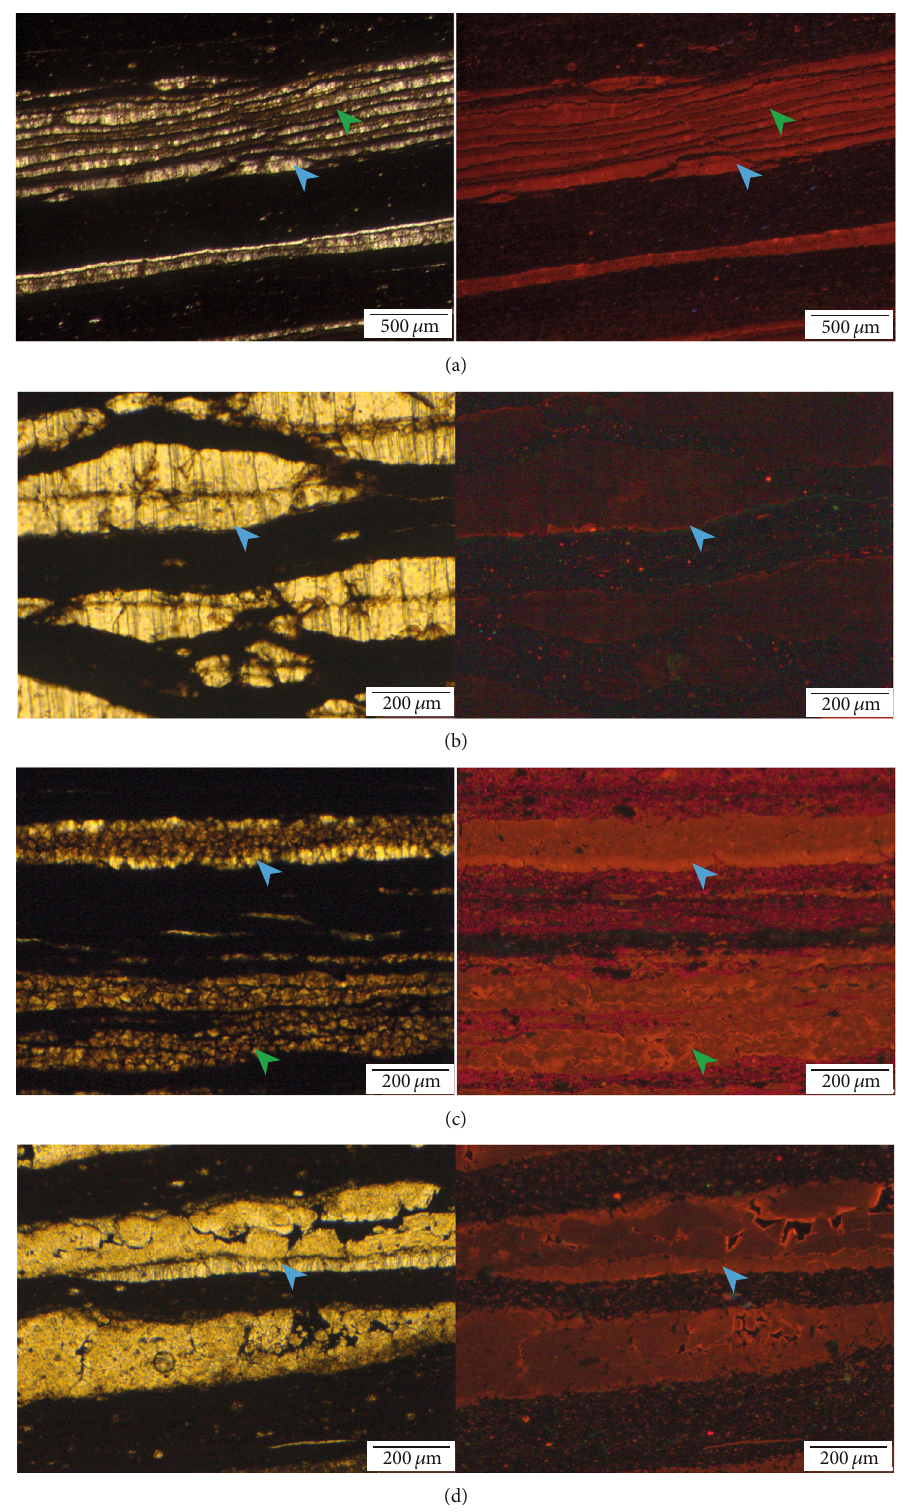
Figure 7: Calcite veins under a cathodoluminescence (CL) microscope. (a) NY1, 3414.23m: the micritic carbonates are in the median zone (green arrow) fl anked with fi brous crystals (blue arrow) or towards one side of the vein. Fibrous calcite crystals with brighter red luminescence contrast to the median zone. (b) NY1, 3296.06m: fi brous calcite crystals show dark luminescence, but the edge of the vein is brighter (blue arrow). (c) NY1, 3458.57m: blocky crystals have oscillatory zoning (green arrow), and the edge of the fi brous crystals have brighter luminescence (blue arrow). (d) FY1, 3418.35m: fi brous calcite shows brighter luminescence (blue